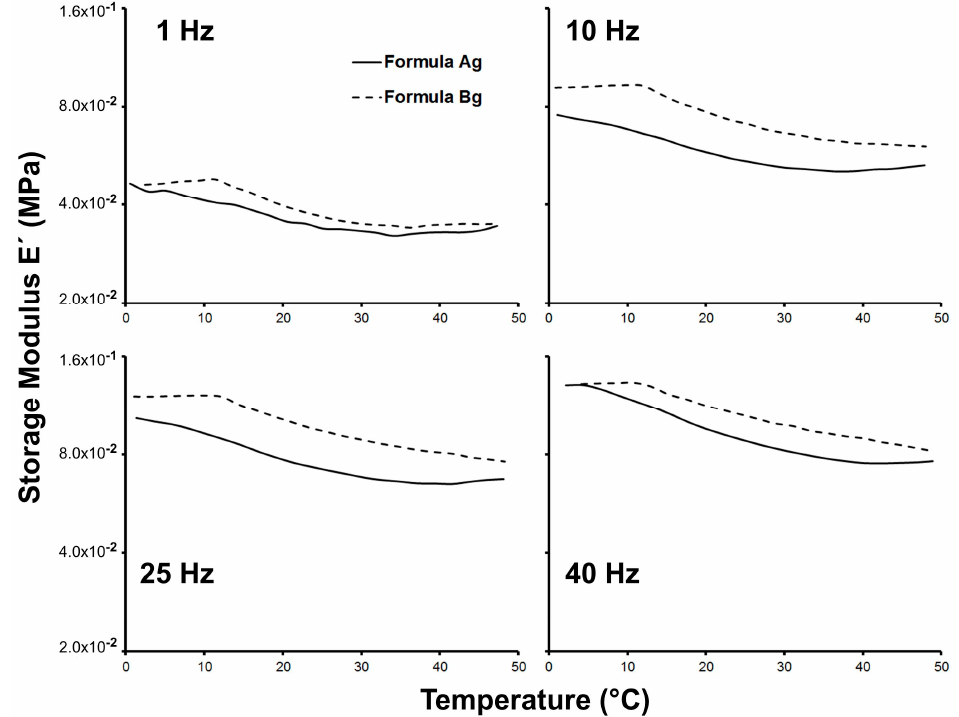
Figure 6. Stiffness of the wet scaffolds.